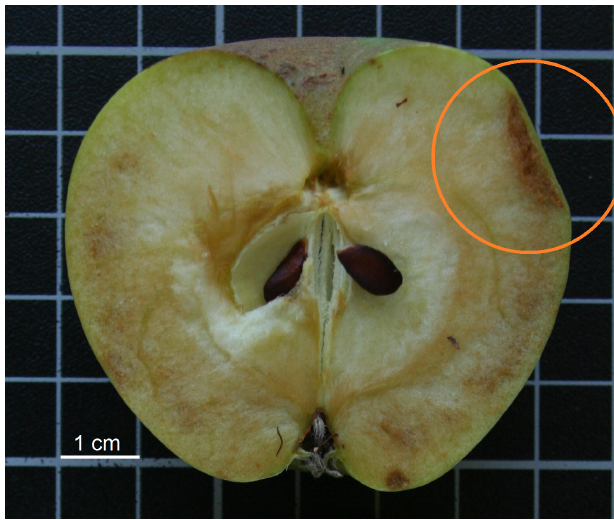
Figure 6. Apple damaged due to lack of growth space, possibly triggered by the presence of a short or wide